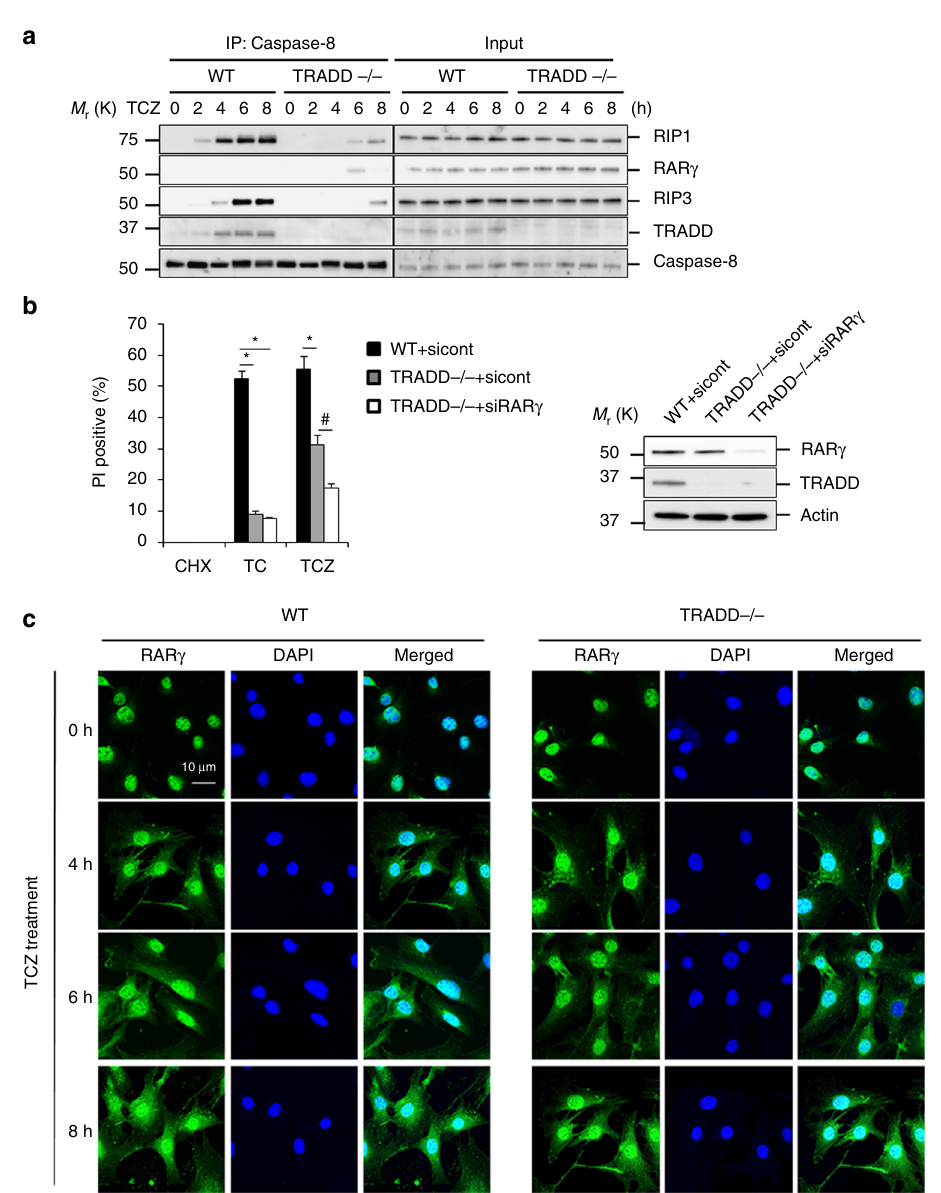
Fig. 8 RAR γ is involved in TCZ-induced necroptosis in TRADD − / − MEFs. a WT and TRADD − / − MEFs treated with TCZ for the indicated times. Cell lysates were immunoprecipitated using anti-Caspase-8 antibody and immunoblotted with the indicated antibodies. b WT or TRADD − / − MEFs transfected with sicont or siRAR γ were treated with TSZ for 24 h. Cell death was determined by PI staining using fl ow cytometry ( left panel ). Western blot analysis of cells as mentioned in left panel ; cell lysates were probed with antibodies as indicated ( right panel ) (* P < 0.05 versus WT + sicont. # P < 0.05 versus TRADD − / − + sicont; ANOVA). The bars represent the mean ± s.e.m. of three experiments. c WT and TRADD − / − MEFs treated with TCZ in indicated time points. The localization of endogenous RAR γ assessed by immuno fl uorescent staining ( blue : DAPI; green : RAR γ ) ( scale bar : 10 μ m). All blots and images above are representative of one of three